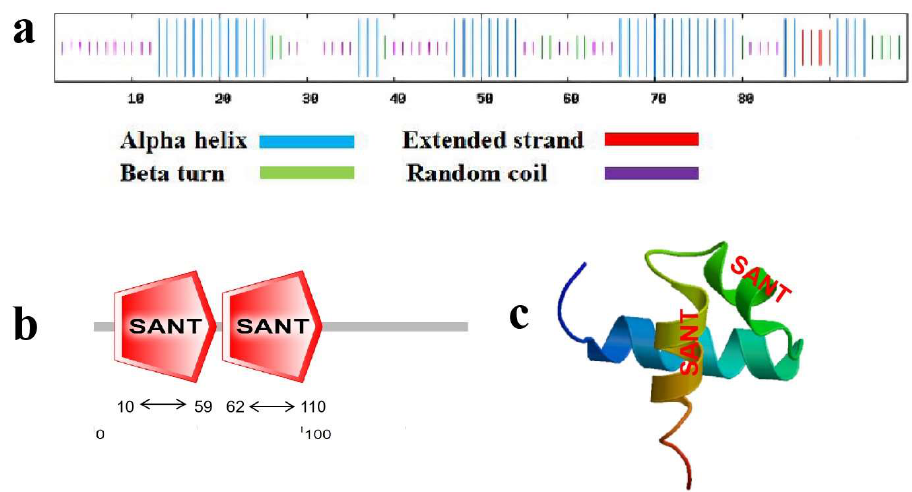
Figure 2. Predicted FvMYB44 protein structure and domains. ( a ) prediction of protein secondary structure; ( b ) prediction of protein domains; ( c ) prediction of tertiary structure.